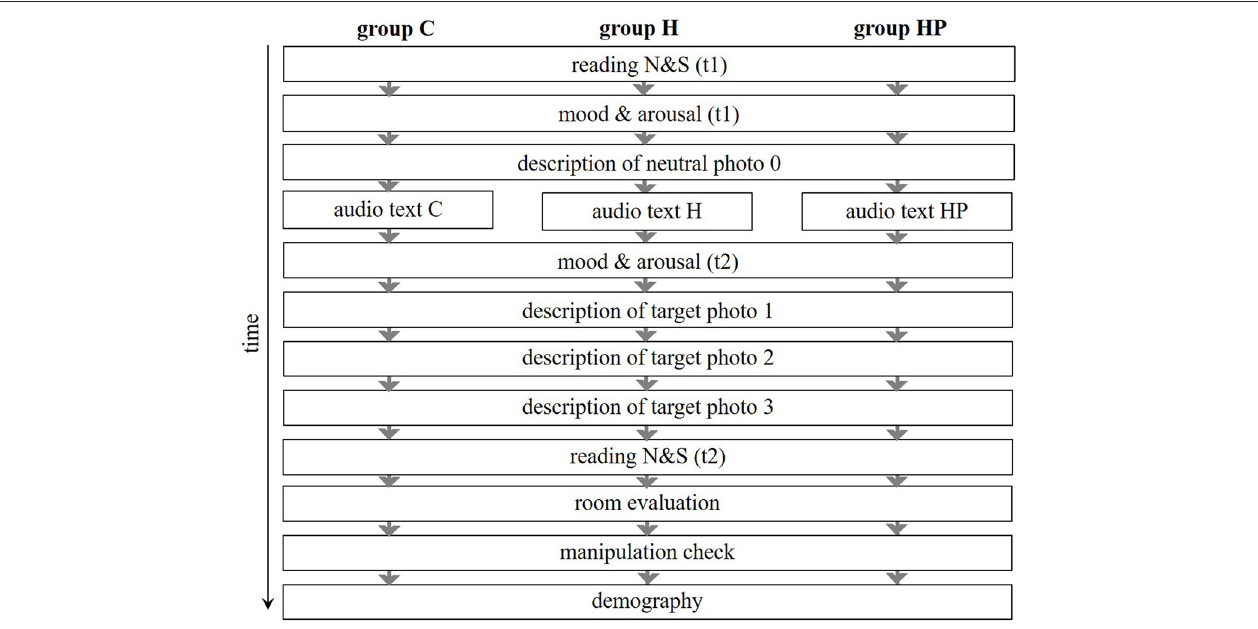
FIGURE 4 | Procedure of Study 2. C, control group; H, history awareness group; HP, history and place awareness group.